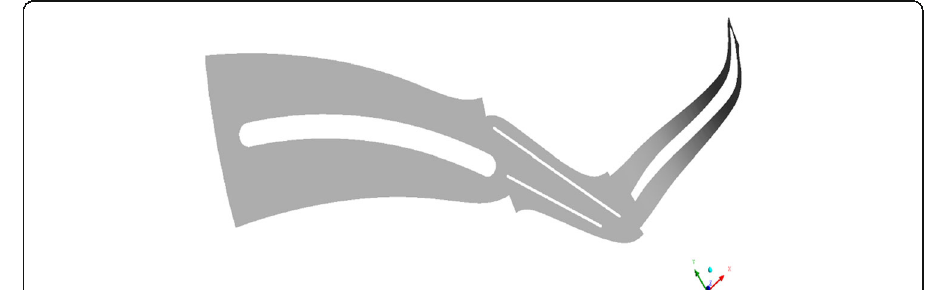
Fig. 7 Blade to blade view of the impeller and